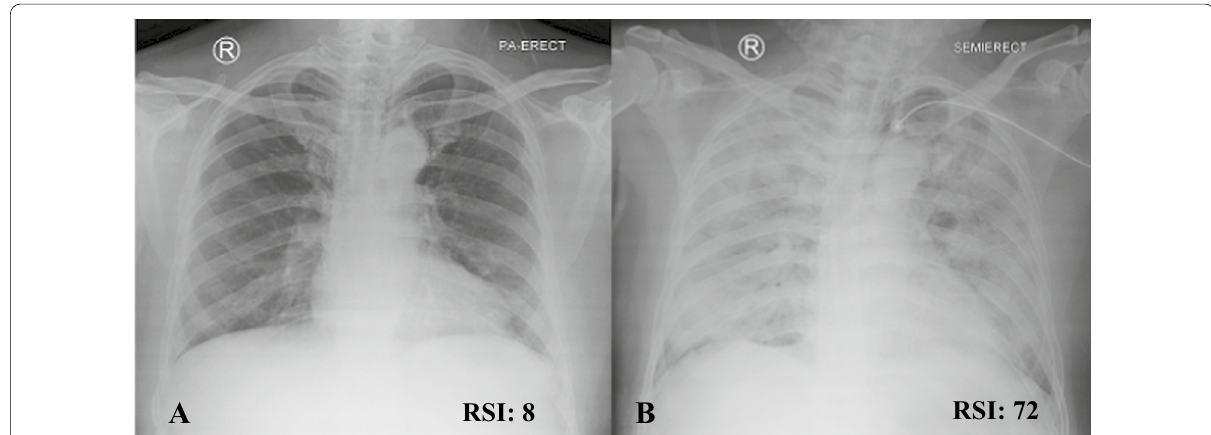
Table 4 Logistic regression test of CURB-65 RSI1 and CURB-65 RSI2 + + B S.E Wald df Sig Exp (B)